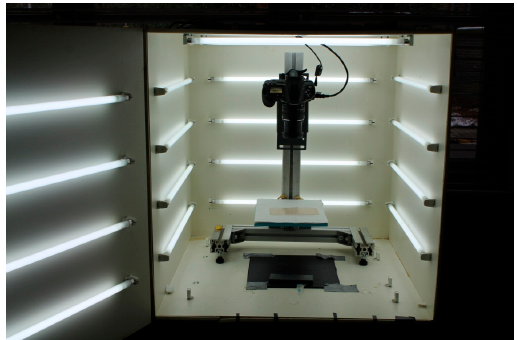
Figure 2. Box with uniform illumination and the RGB-camera used for high-resolution digital image recording.